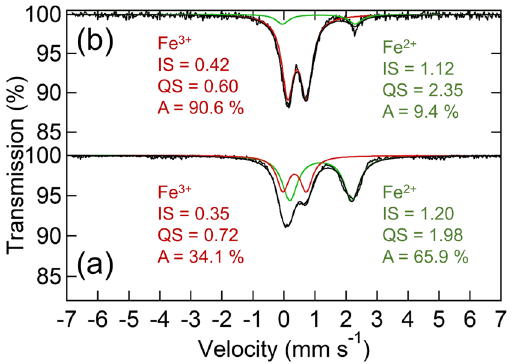
Figure 2. 57 Fe Mössbauer spectroscopy of the MM_NFPC/C kept in an Ar-filled glovebox ( a ); exposed in air ( b